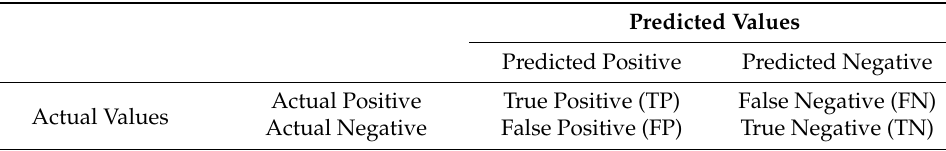
Table 2. Confusion